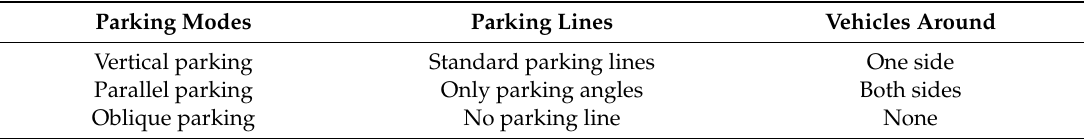
Figure 15. Oblique parking mode. 5. Experiments The experiment was made up of the hardware parts, as shown in Figure 16, and the software parts. The hardware consisted of a grid laser emitter with a 51 × 51 laser grid on the ground and a camera, while the software part consisted of image processing and obstacle detection by the on-board computer. The implementation of the software part was done using C++ with Visual Studio 2017 as the development environment using OpenCV library Version 3.4.4 for image processing and obstacle detection. ( b ) Figure 16 . Experiment platform. ( a ) front view; ( b ) side view. In order to verify the effectiveness of the proposed method for identifying parking spaces and obstacles based on vision sensors and laser devices, various obstacles and scenes encountered in real- life parking environments were simulated and tested by the experimental platform in Figure 16. The laser transmitter and the camera mounted on the vehicle were simulated on the experimental